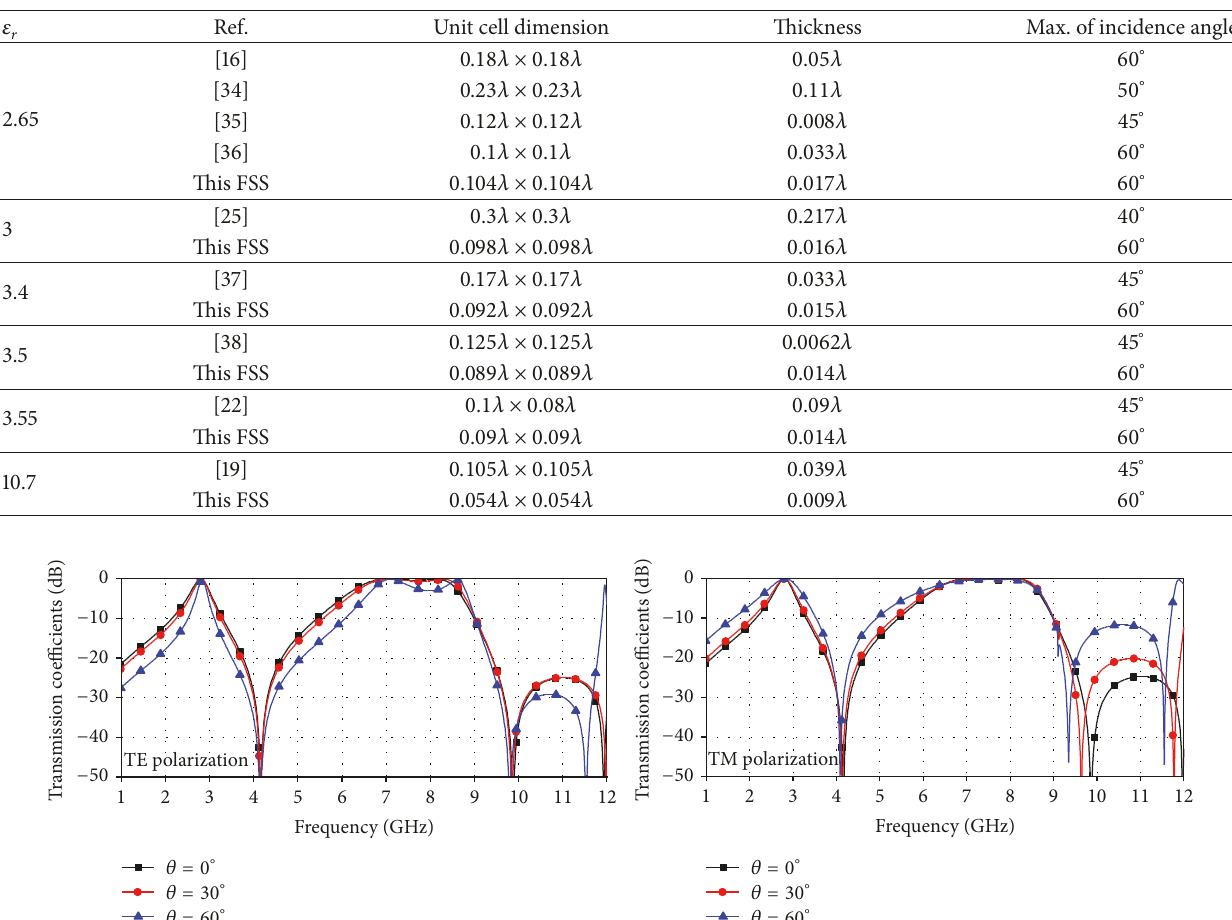
Table 2: Results comparison to other multilayered and 3D FSS structures.